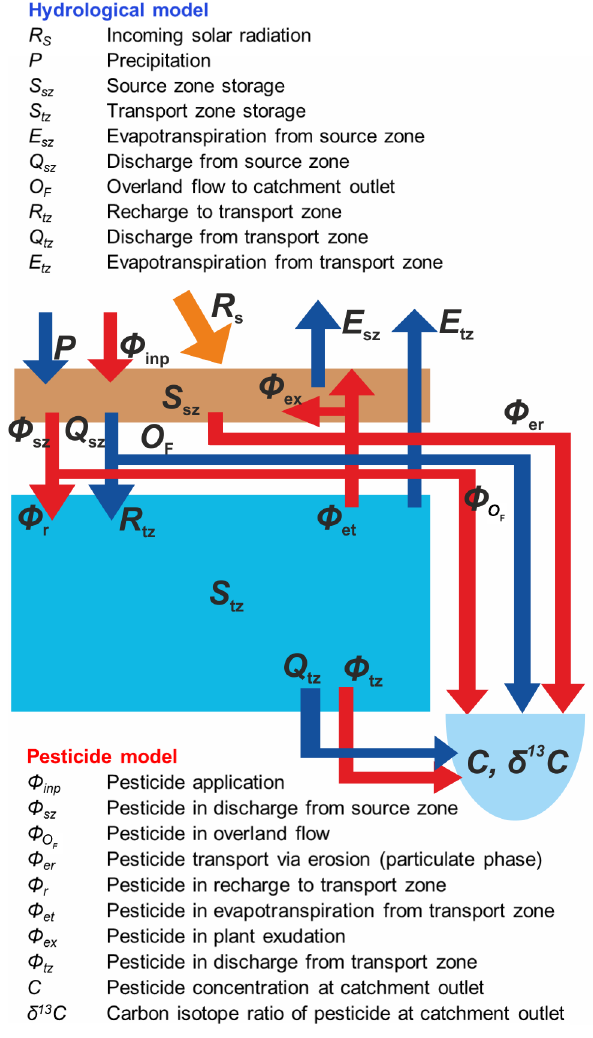
Figure 2. Model scheme showing water flow (blue arrows) and pes- ticide transport routes (red arrows) from the source zone (brown box) and transport zone (blue box) to the catchment outlet (light blue